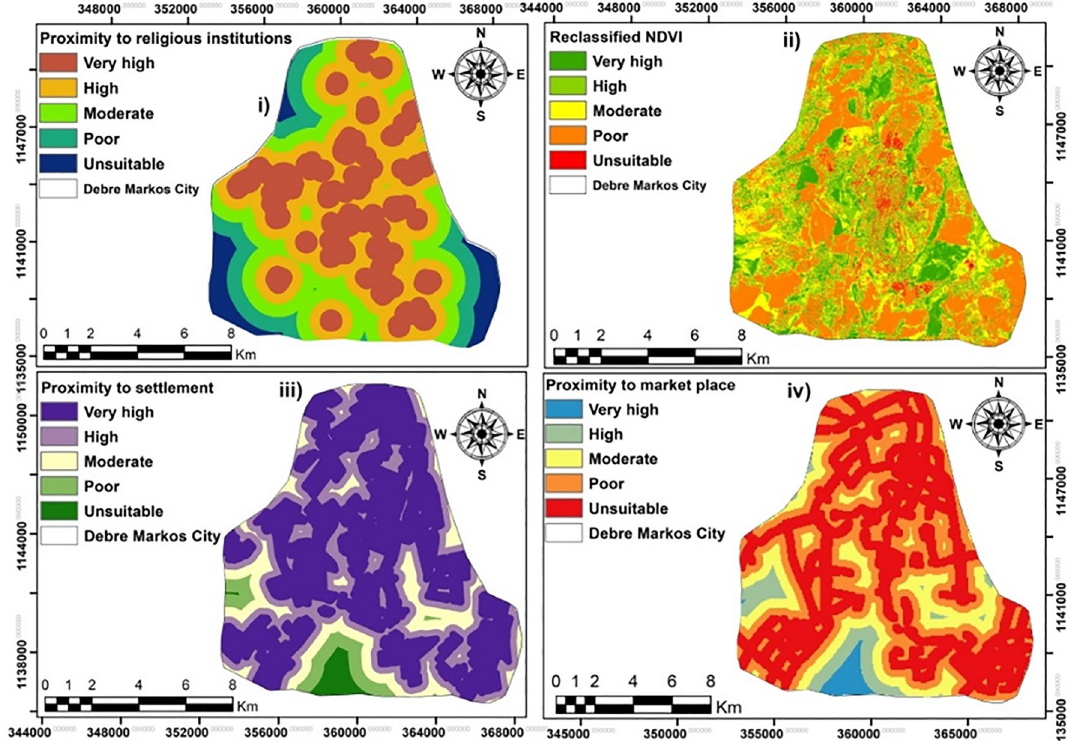
Fig. 8 reclassified maps of i proximity to the religious institution ii NDVI iii proximity to settlement iv Proximity to